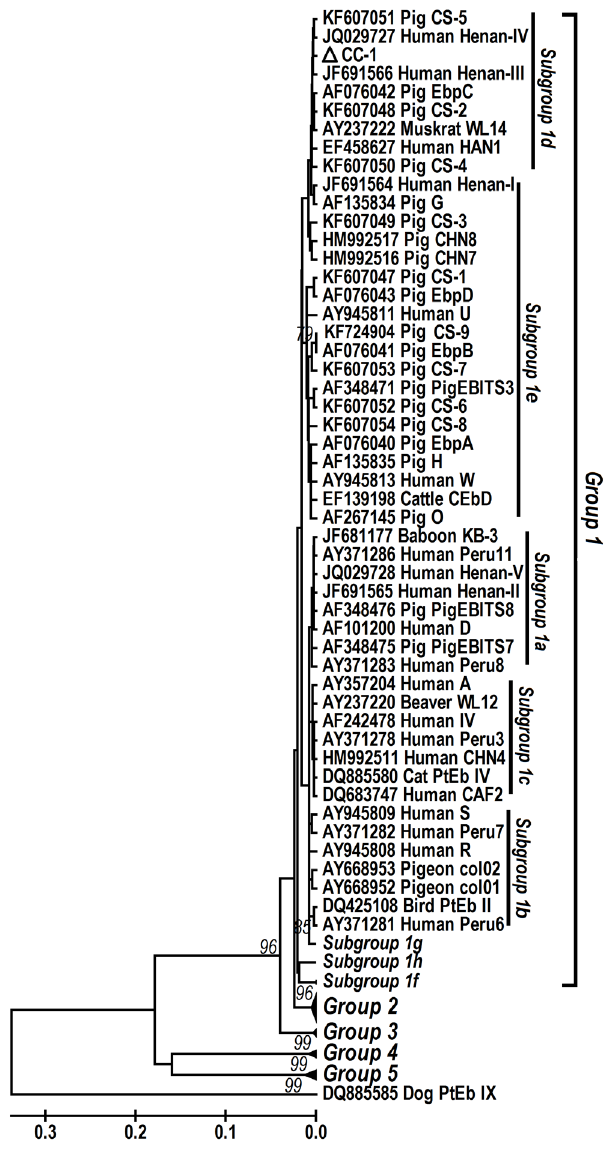
Figure 2. Phylogenetic relationship of ITS nucleotide sequenc- es of Enterocytozoonbieneusi in this study and known E.bieneusi genotypes, as inferred by a neighbor-joining analysis (Mega 4 software [ http://www.megasoftware.net/ ]) based on genetic dis- tances calculated using the Kimura two-parameter model. The ITS tree was rooted with GenBank sequence DQ885585. Bootstrap values less than 65% from 1,000 pseudoreplicates are not shown. CC-1 indicated by white triangle is a new genotype found in this